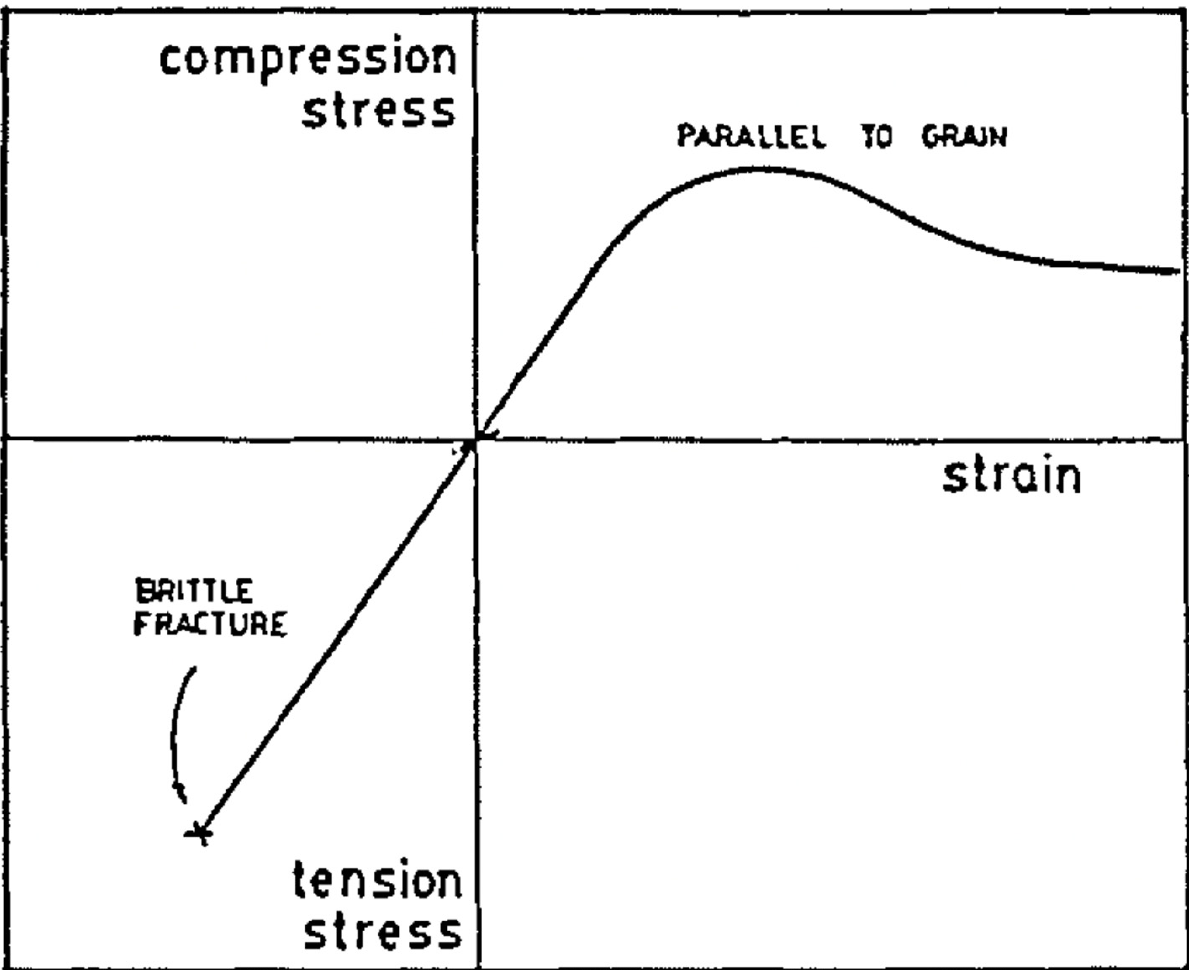
Figure 11. Schematic diagram showing the asymmetry of the tensile and compressive response of defect-free (or ‘clear’) wood. From [86].